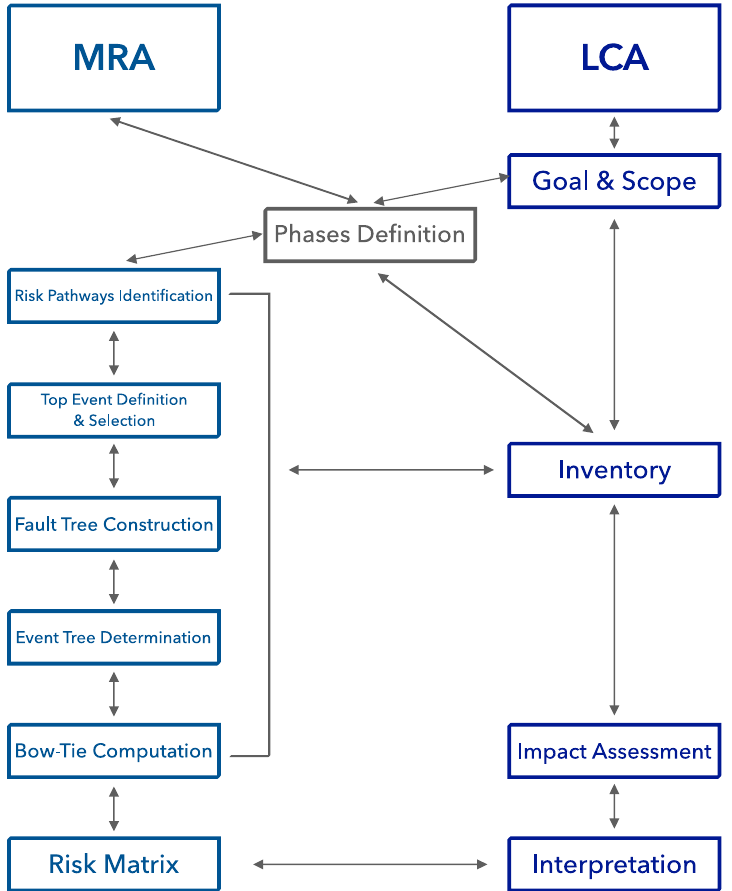
Figure 6. Schematic of our integration protocol for LCA and MRA.